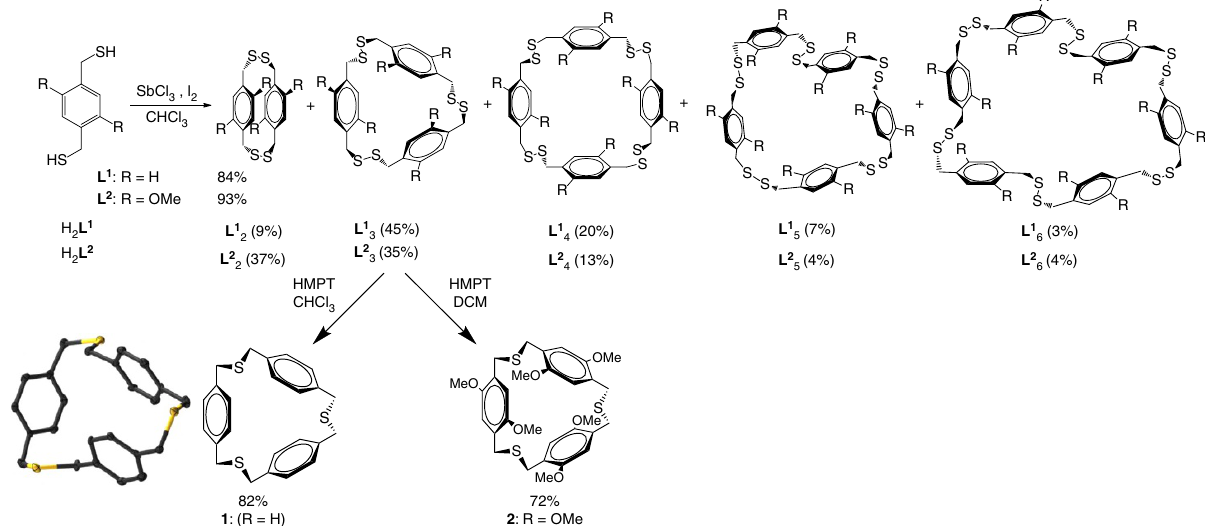
Figure 1 | Synthesis and crystal structure of disulfide and thioether paracyclophanes. Pnictogen-activated iodine oxidation of H 2 L 1 and H 2 L 2 to form disulfide macrocycles ( B 1 equiv ligand, 0.5 equiv SbCl 3 ; 2 equiv I 2 ): L 1,2 2 (dimer), L 1,2 3 (trimer) and L 1,2 4 (tetramer); ( L 1,2 5 pentamers and L 1,2 6 hexamers are not shown, see single crystal structures of L 1 5 and L 1 6 in Supplementary Fig. 1). Overall isolated yields for the self-assembly are 93% and 84%, respectively for H 2 L 1 and H 2 L 2 . The distribution of each disulfide macrocycle formed at B 2mM reaction conditions are shown. There is no evidence of oligomer/polymer formation by NMR or post GPC purification. Desulfurization of disulfide trimers yields thioether macrocycles 1 and 2 (single crystal X-ray structure representations of 1 shown with thermal ellipsoids at 50%. Hydrogen atoms and solvents of crystallization have been omitted for